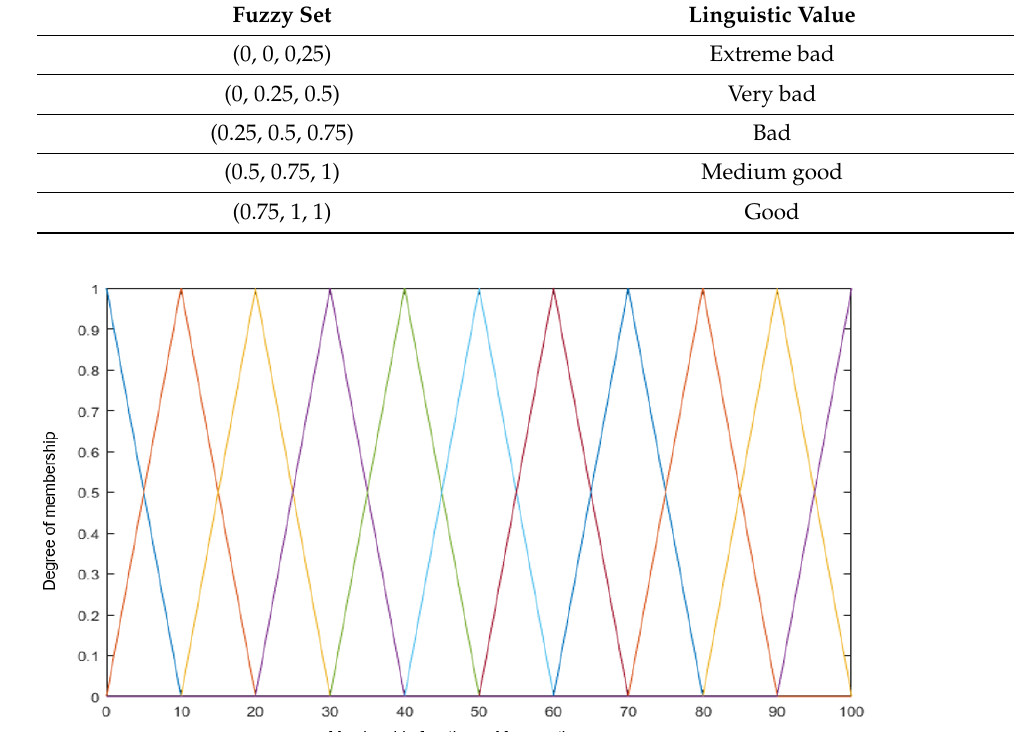
Figure 2. Membership functions of fuzzy sets of elements ratings.